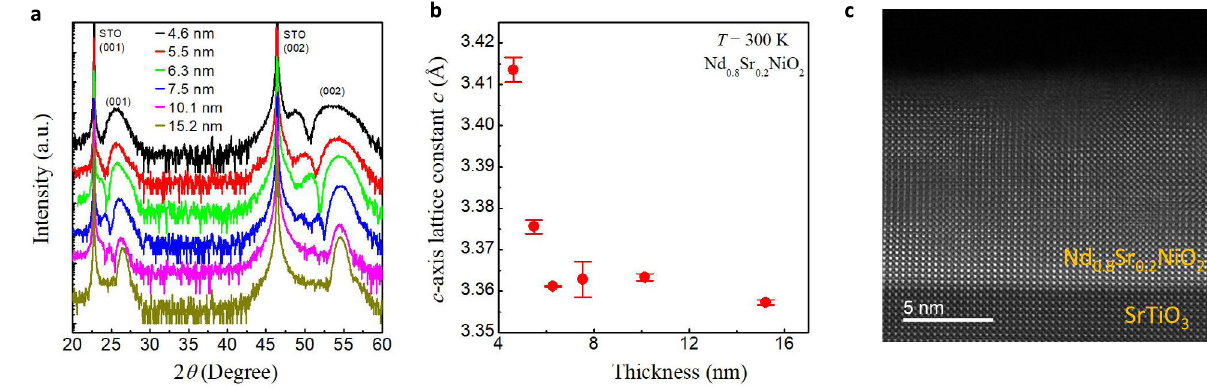
Fig. 1 Thickness dependence of the in fi nite layer structure. a The XRD θ – 2 θ scan patterns of the Nd 0.8 Sr 0.2 NiO 2 thin fi lms with different thicknesses on SrTiO 3 substrates. The intensity is vertically displaced for clarity. b The room-temperature c -axis lattice constants, c , as a function of thickness, as calculated from the (001) peak positions. The red dots represent the average c of the two sets of samples and the error bars represent the variance. c The HAADF-STEM image of the 10.1-nm Nd 0.8 Sr 0.2 NiO 2 on SrTiO 3